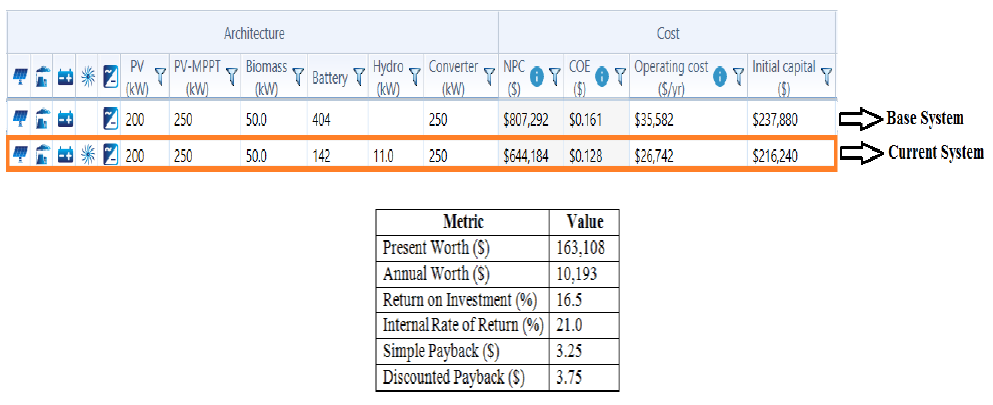
Figure 30. Comparative economical study for case IV (Ba/Bi/H/S).